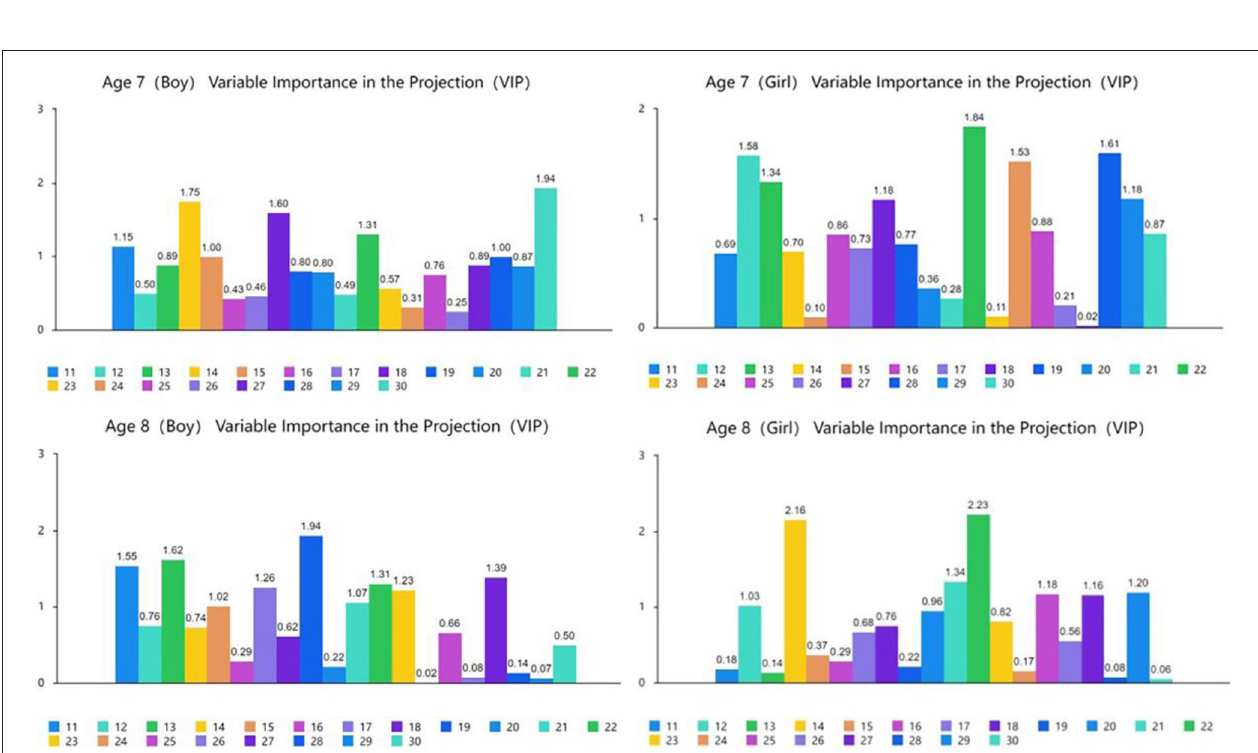
FIGURE 9 | VIP chart of the projection importance index of motor behavior on motor development.